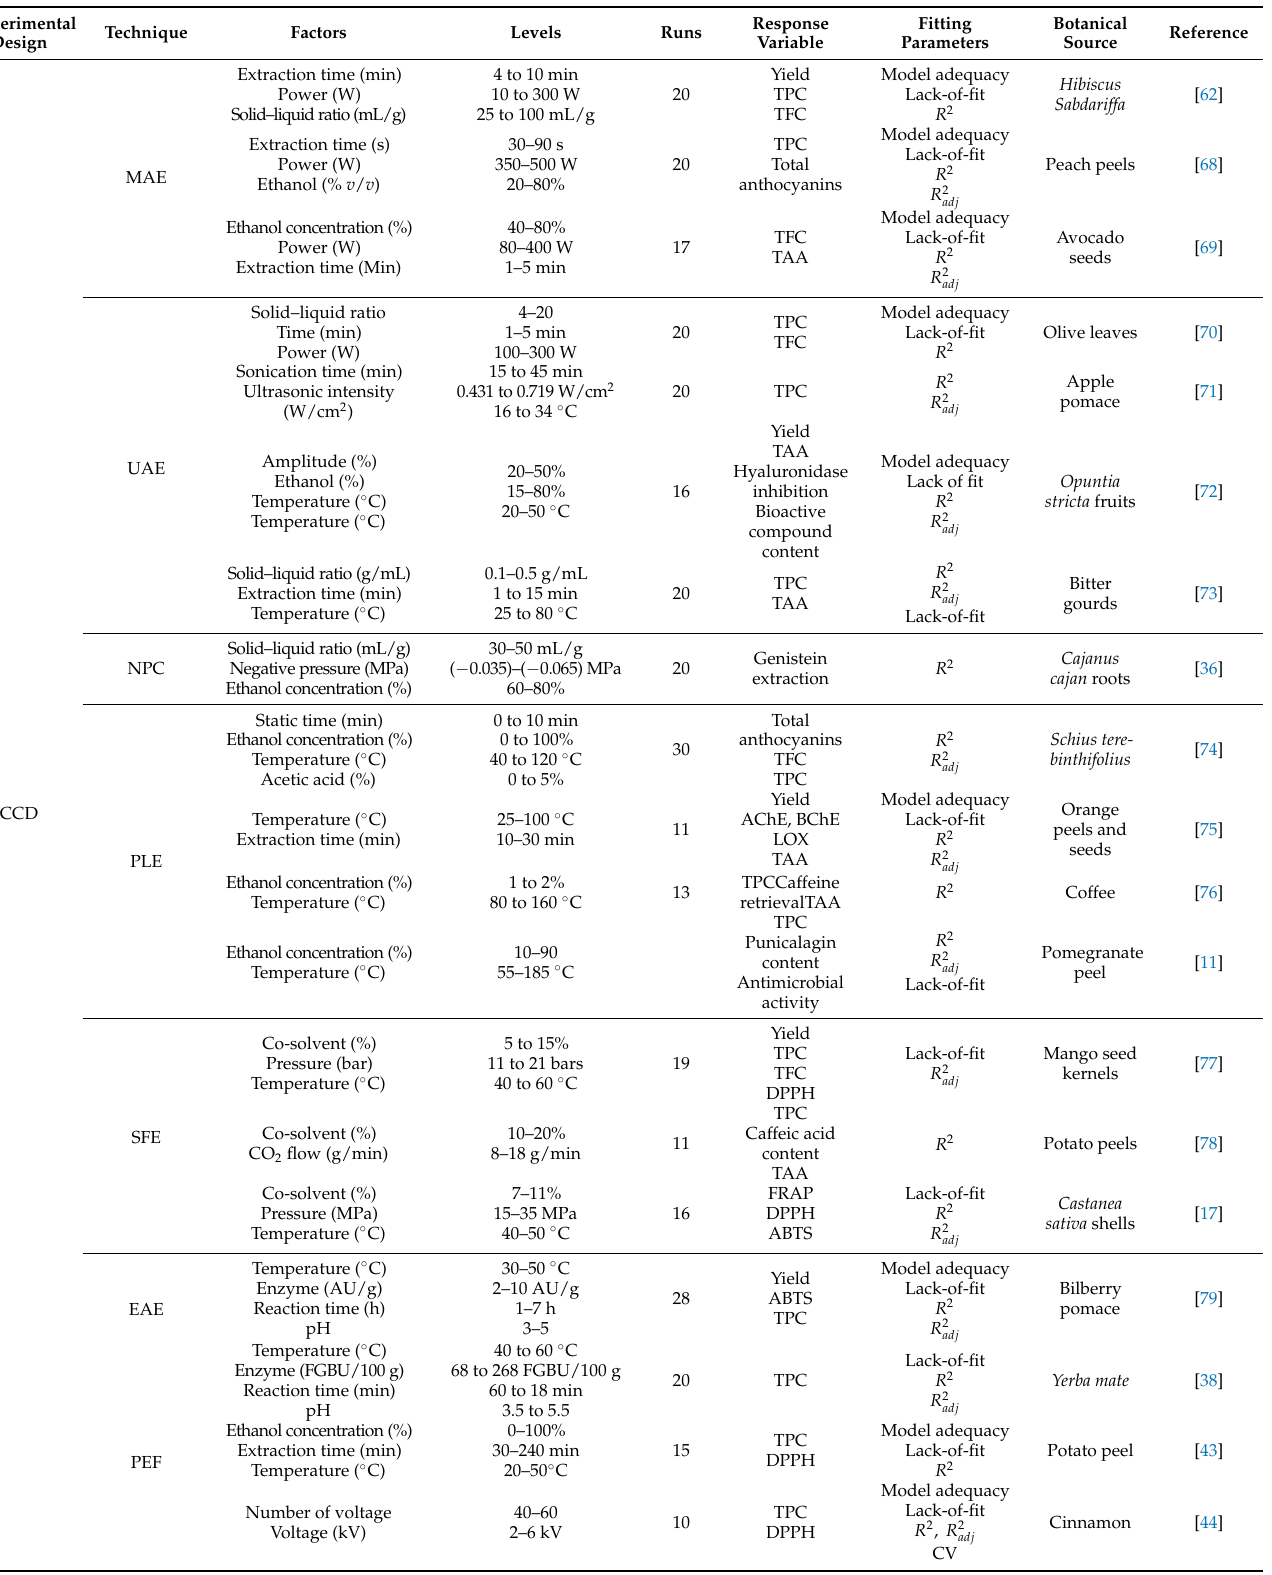
Table 4. Application of DoE in advanced extraction